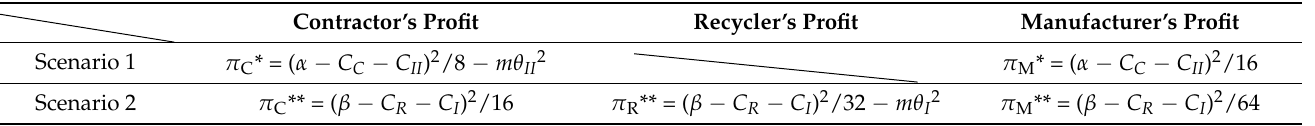
Table 2. Comparison of profits in scenario 1 and scenario